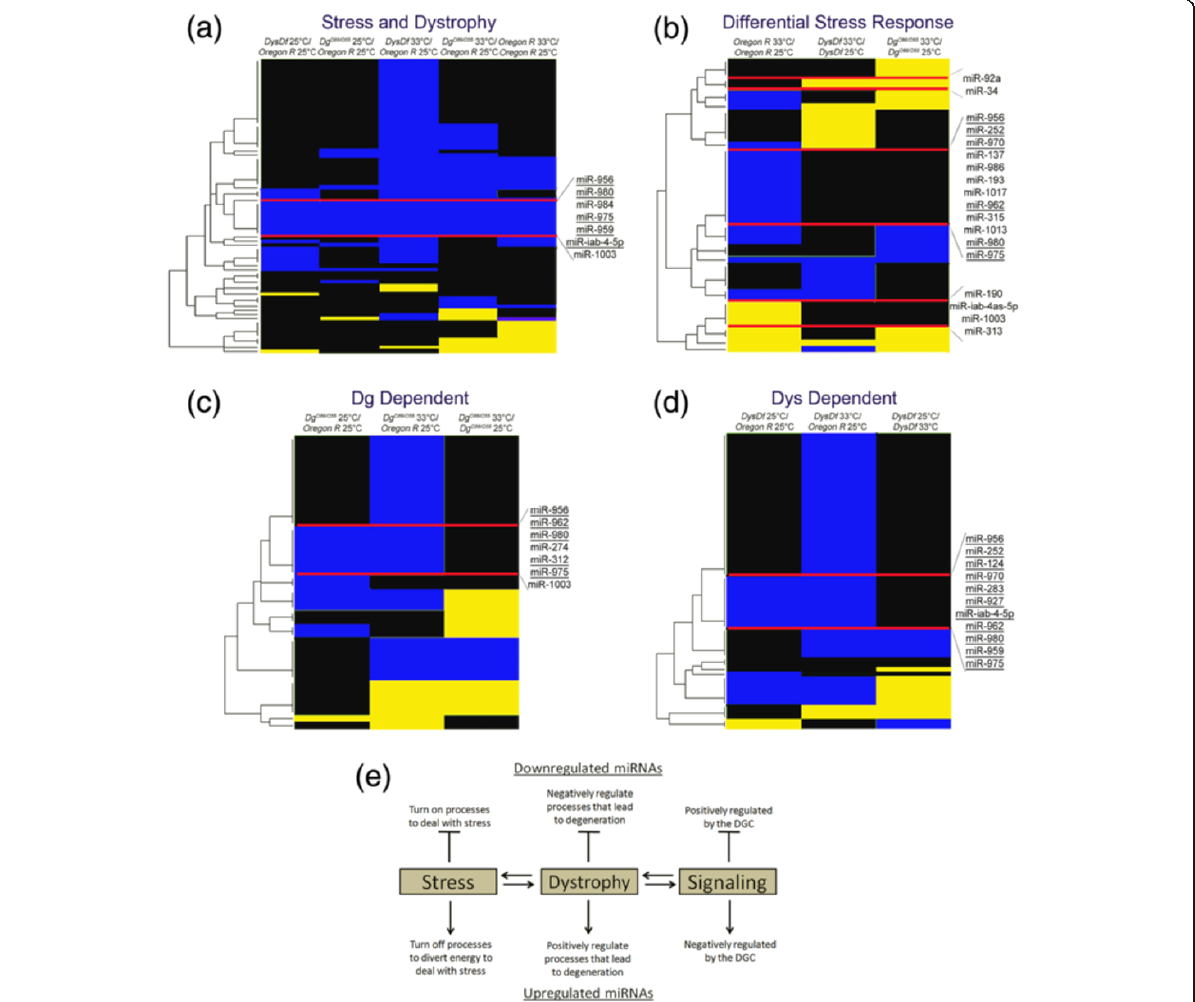
Figure 2 Altered miRNAs are shared among functionally relevant categories. ( a - d ) Heatmaps of altered miRNAs grouped into functionally relevant categories: only miRNAs that were altered in the indicated comparisons were included in generating the heatmaps per grouping. Underlined miRNAs were further tested for microarray agreement via q-PCR. ( a ) Combination of both hyperthermic stress and dystrophy, ( b ) differential response based on stress in mutants, ( c ) dependent on the loss of Dg and ( d ) dependent on the loss of Dys. ( e ) Stress, dystrophy and Dg/Dys signaling all can cause altered levels of miRNAs that are common among each category showing a functional link in these